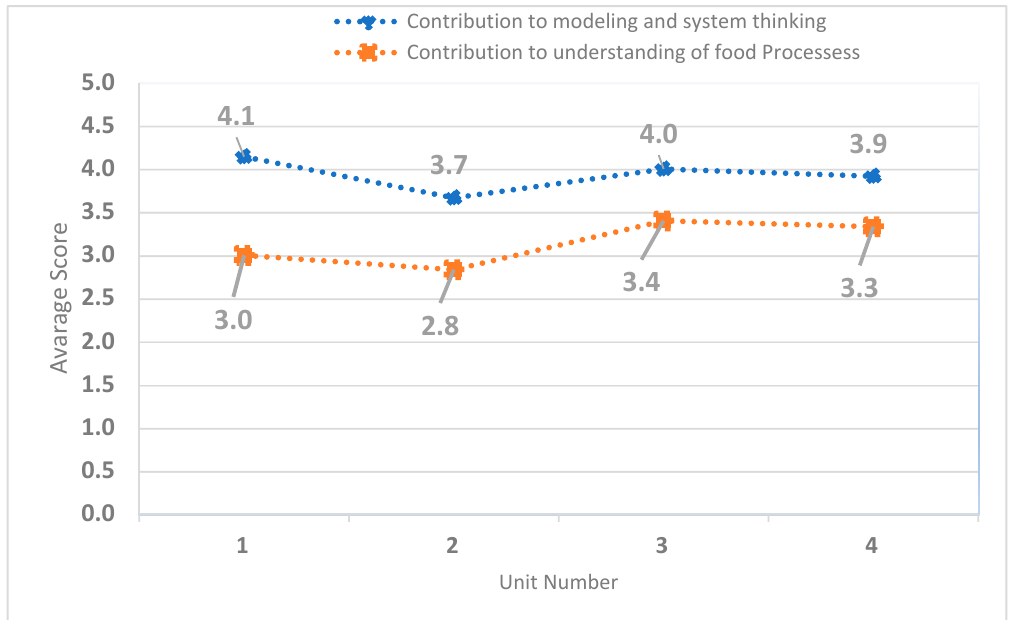
Figure 8. Students’ feedbacks regarding systems thinking, modeling, and understanding of food processes.